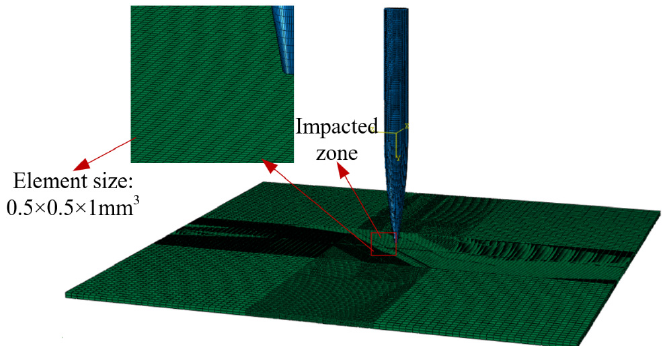
Figure 8. Mesh model.